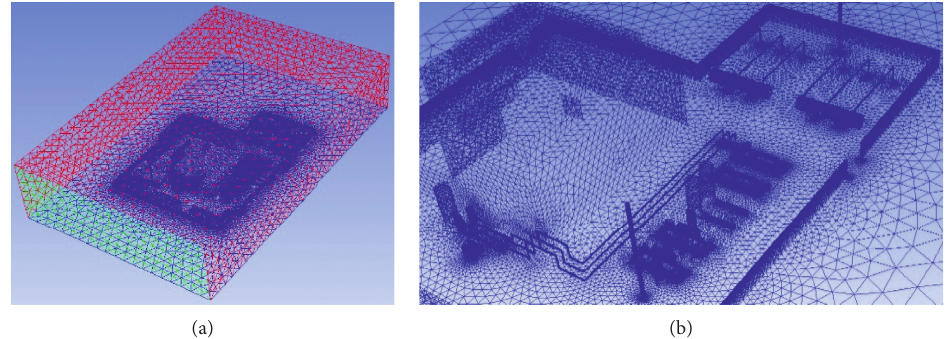
Figure 12: Numerical model of the injection station. (a) Surface grid of the calculate zone. (b) Enlarged partial grid.